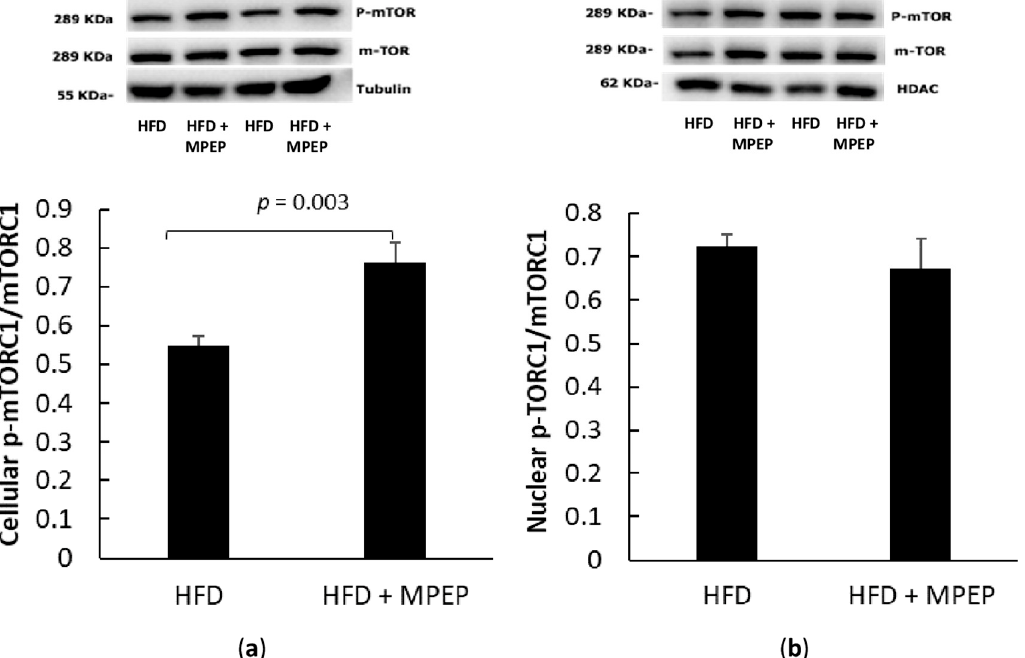
Figure 6. Activation of cellular and nuclear mTOR in obese mice. ( a ) activated mTOR in liver homogenates from ob/ob mice after 7 weeks of HFD administration and treatment with MPEP 20 mg/Kg or vehicle; ( b ) activated mTOR in nuclear extracts from ob/ob mice after 7 weeks of HFD administration, treated with MPEP 20 mg/Kg or vehicle. HFD: high-fat diet + vehicle group; HFD + MPEP: high-fat diet + 20 mg/Kg MPEP group. Results are mean ± SE of 6 individual determinations. Ribosomal protein S6 kinase, polypeptide 1 (S6K1), and eukaryotic translation initiation factor 4E binding protein 1 (4E-BP1) are target genes of mTORC1: RT-PCR analysis in hepatic tissue from ob/ob mice after 7-week HFD treated with MPEP (20 mg/Kg) or vehicle was performed to investigate any changes in mTORC1 downstream genes. A significant decrease in the mRNA expression of both considered genes, S6K1 (Figure 7a, p = 0.05) and 4E-BP1 (Figure 7b, p = 0.0017) respectively, was found in the MPEP-treated group